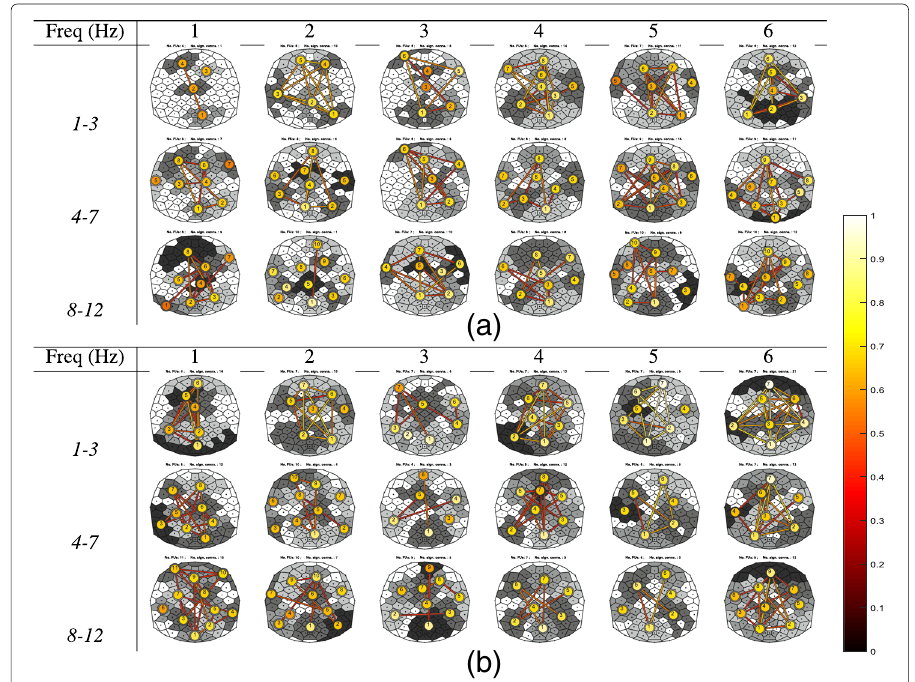
Fig. 9 FU CCB maps ( | FU | ≥ 5) for 6 younger adults and 6 older adults for three frequency bands (1-3, 4-7, and 8-12 Hz). Each FU is visualized as a set of Voronoi cells with identical gray values and with different gray values for adjacent FUs. White Voronoi cells are part of FUs, with | FU | < 5. A line connects FUs if the inter-FU coherence exceeds the significance threshold, with its color depending on the value (see color bar, bottom right). The color of the circle located at the barycenter of each FU reflects the average coherence within FUs. a Young participants. b Old